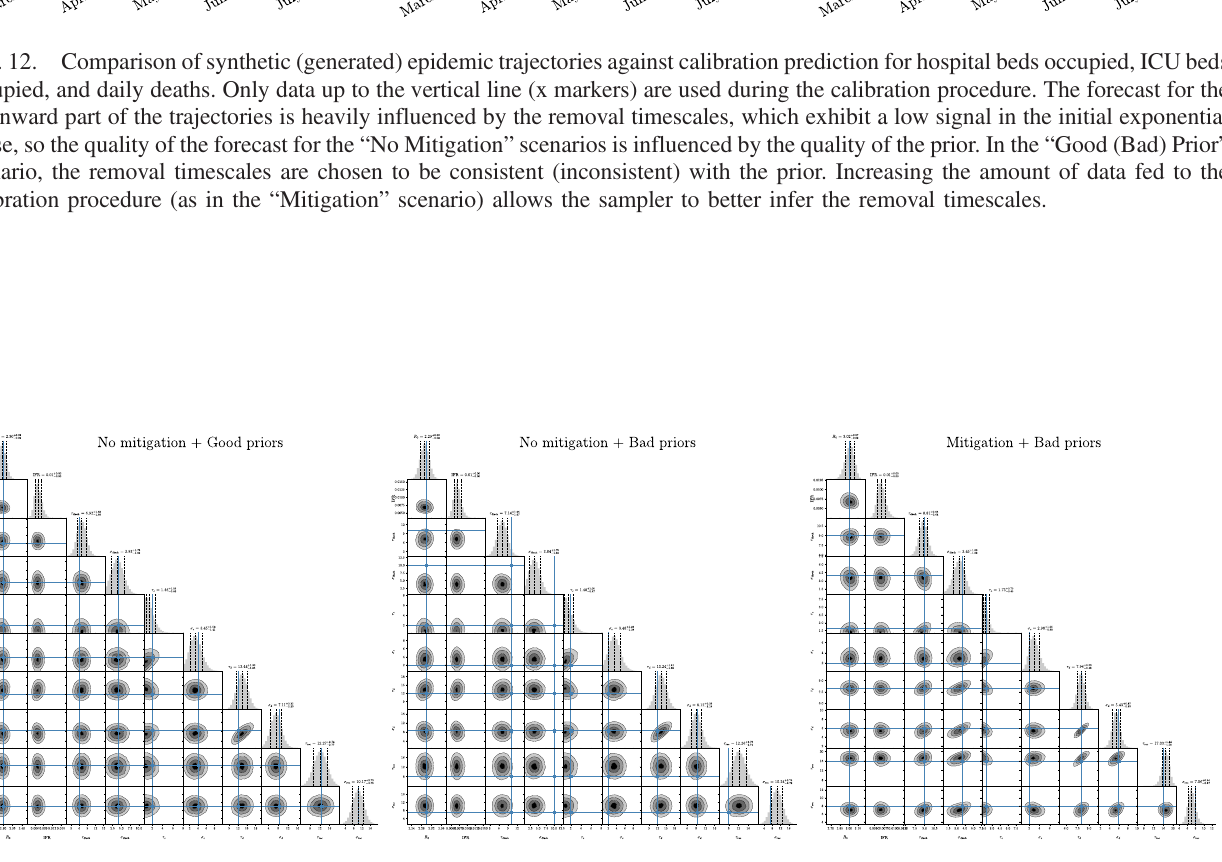
FIG. 13. Estimate of posterior probability distribution for synthetic data calibration tests shown in Fig. 12. Blue lines or points show the values of parameters used to generate the synthetic data set. In the “ No Mitigation + Bad Priors ” scenario, the truth values for some of the removal timescales were chosen to lie well beyond the prior since the calibration data did not include the downward part of the trajectory. By including data from after the peak, as is done for the “ Mitigation + Bad Priors ” scenario, the removal timescales can be better